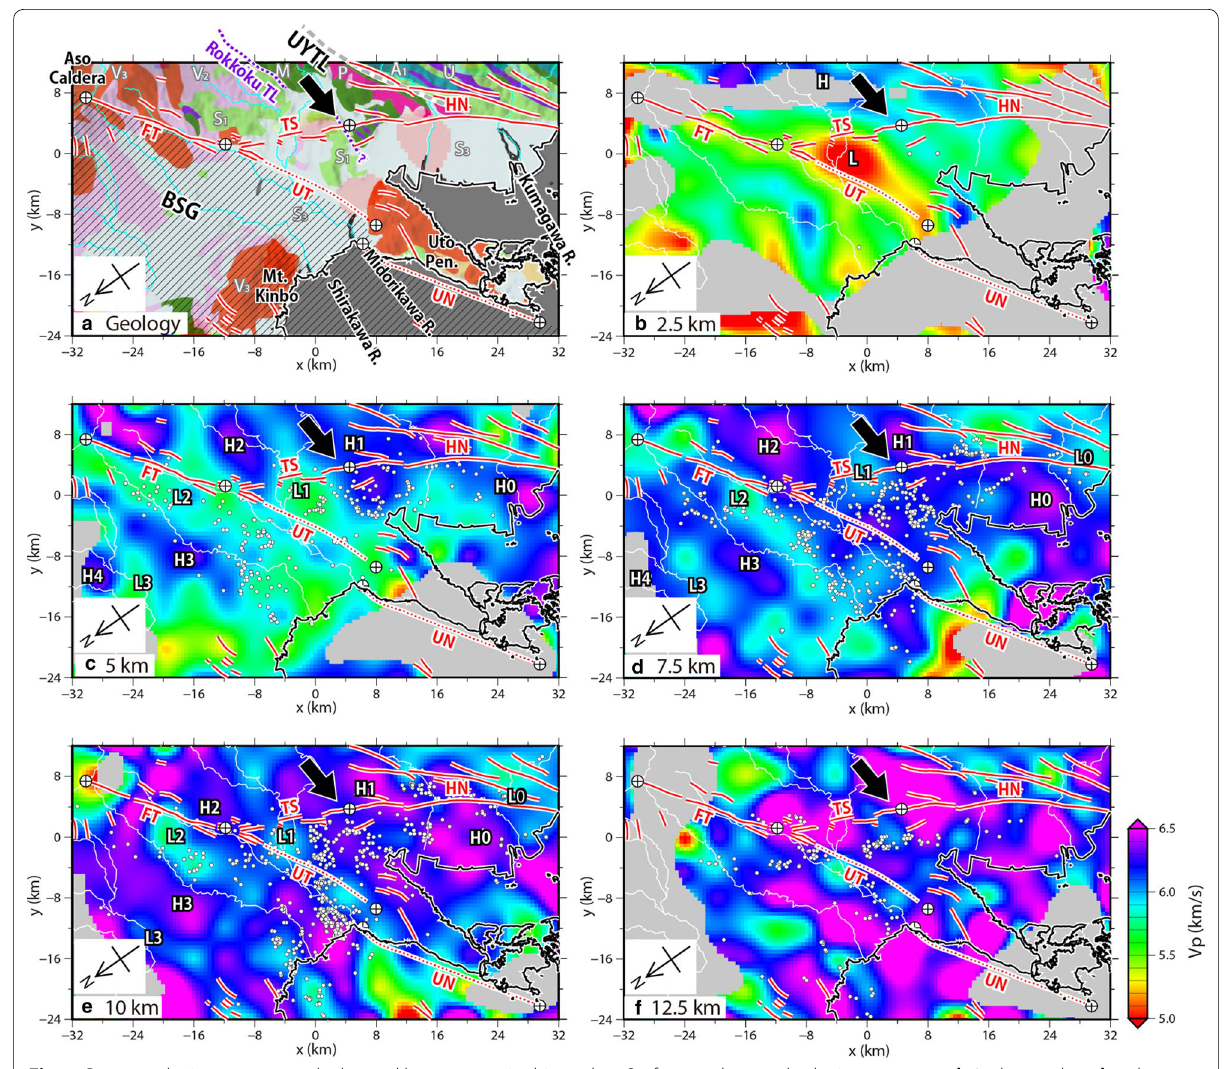
Fig. 5 P-wave velocity structure and relocated hypocenters in this study. a Surface geology and velocity structure at b 2.5 km, c 5 km, d 7.5 km, e 10 km, and f 12.5 km depth. The white circles indicate the relocated hypocenters within 2.5 km of each depth slice. The solid and dashed red lines denote the active faults determined by RGAF (1991) and HERP (2013), respectively. BSG Beppu–Shimabara Graben, UYTL Usuki–Yatsushiro Tectonic Line, FT Futagawa segment, UT Uto segment, UN north coast of Uto Peninsula segment, TS Takano–Shirahata segment, HN Hinagu segment. The geological classification in a is the same as in Fig. 1. L0–L4 and H0–H4 denote velocity anomalies (patches) that are discussed in the text. The southern termination of the fault rupture, which is estimated during our study, is indicated by the black